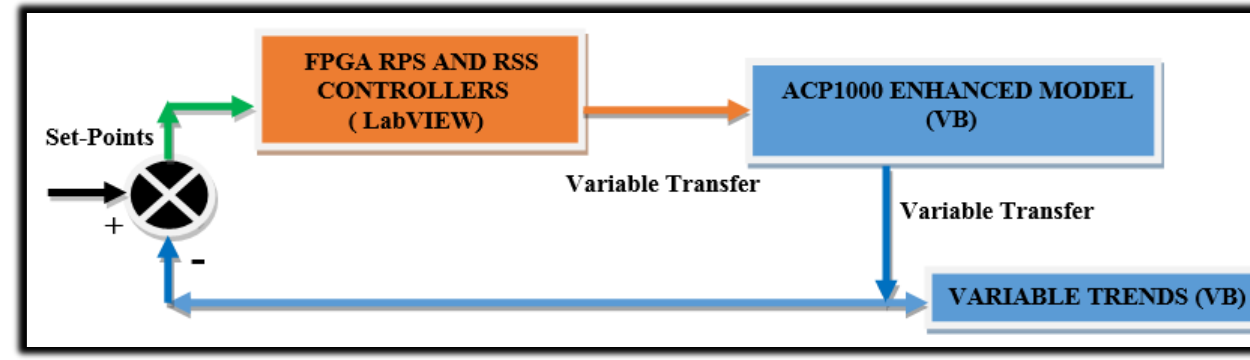
Fig. 2. Framework of process, controllers and display systems